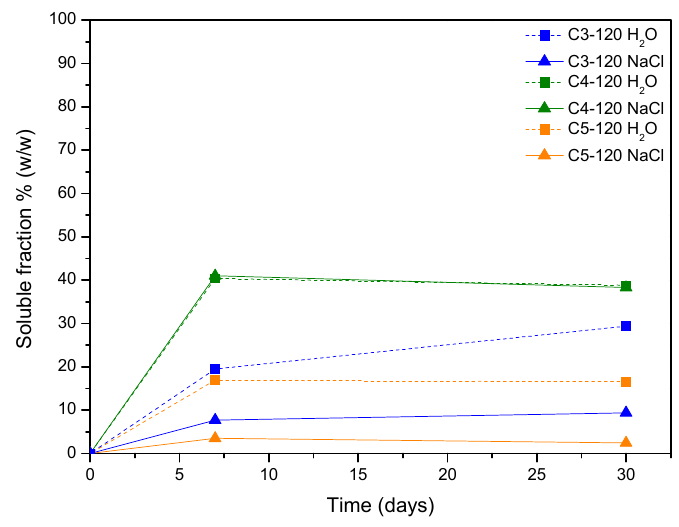
Figure 5. Evolution of soluble fraction % ( w / w ) after immersion in ultra ‐ pure water and aqueous NaCl 1 M solution of cured C3 ‐ 120, C4 ‐ 120, C5 ‐ 120 polymeric coatings.